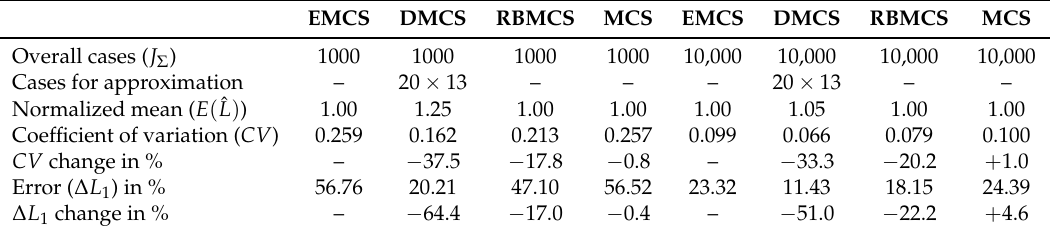
Table 3. Errors and uncertainties in lifetime using different concepts and 1000 as well as 10,000 overall samples; simulation data [18]. Changes (of CV and ∆ L 1 ) refer to the reference approach